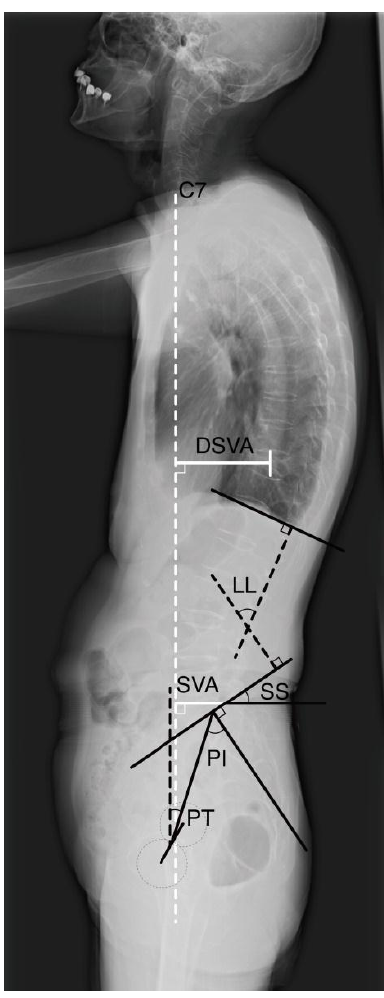
Figure 1. Measurement of spinopelvic parameters, sagittal vertical axis (SVA) and center of the fractured vertebra (DSVA). Owing to the nature and deviation of the spine lateral plain films, we defined the center of the femoral head used in the measurement of this study as the midpoint between femoral head of bilateral side. PI was defined as the angle between the vertical line of the sacral plateau and the line drawn from the mid-sacral plateau to the center of the femoral head. PT was defined as the angle between a line drawn from the mid-sacral plateau to the center of the femoral head and plumb line of the center of the femoral head. SS was defined as the angle between the sacral plateau and a horizontal line. Following Cobb’s method, LL was defined as the angle between the superior endplates of the L1 and S1 vertebrae. SVA was defined as the distance from the posterosuperior corner of S1 to the C7 plumb line. DSVA was defined as the distance between the C7 plumb line and the center of the fractured vertebra.